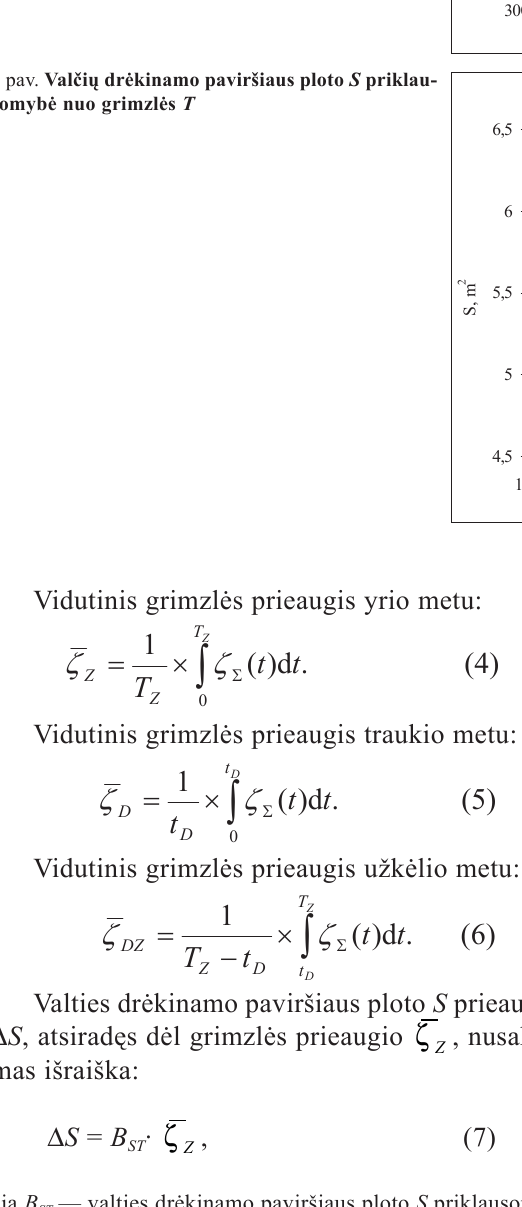
č ia B — valties dr ė kinamo paviršiaus ploto S priklausomy- ST b ė s nuo grimzl ė s T proporcingumo koe fi cientas. Vandens pasipriešinimo j ė ga proporcinga dr ė - kinamo paviršiaus plotui. Tod ė l laisvojo